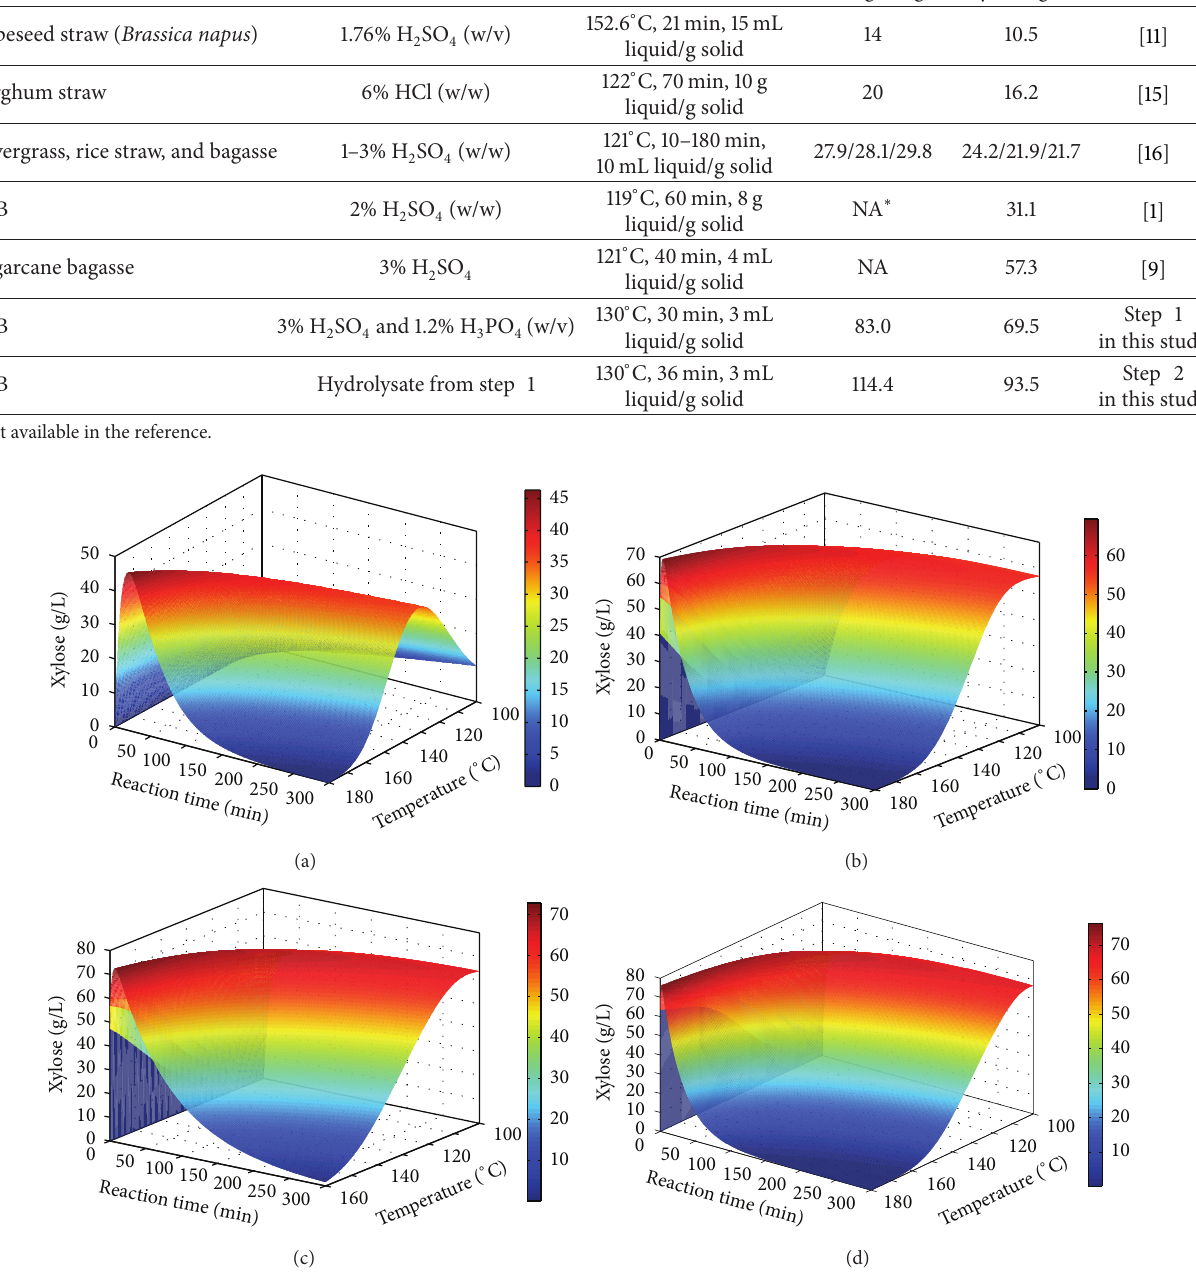
Figure 4: Predicted 3-dimentional changes of xylose concentration at different acid concentrations. (a) 1% (w/v) H 2 SO 4 and 0.4% (w/v) H 3 PO 4 ; (b) 2% (w/v) H 2 SO 4 and 0.8% (w/v) H 3 PO 4 ; (c) 2.5% (w/v) H 2 SO 4 and 1% (w/v) H 3 PO 4 ; (d) 3% (w/v) H 2 SO 4 and 1.2% (w/v) H 3 PO 4 . Other assumed conditions: liquid to solid ratio 3mL/g, 100–180 ∘